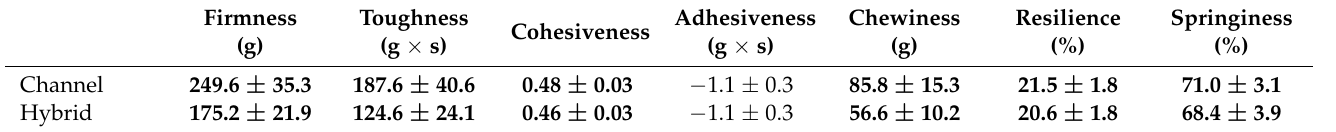
Table 2. Overall instrumental textural differences 1 between cooked Channel and Hybrid catfish fillets. 2 Values expressed as mean ± standard deviation ( n =